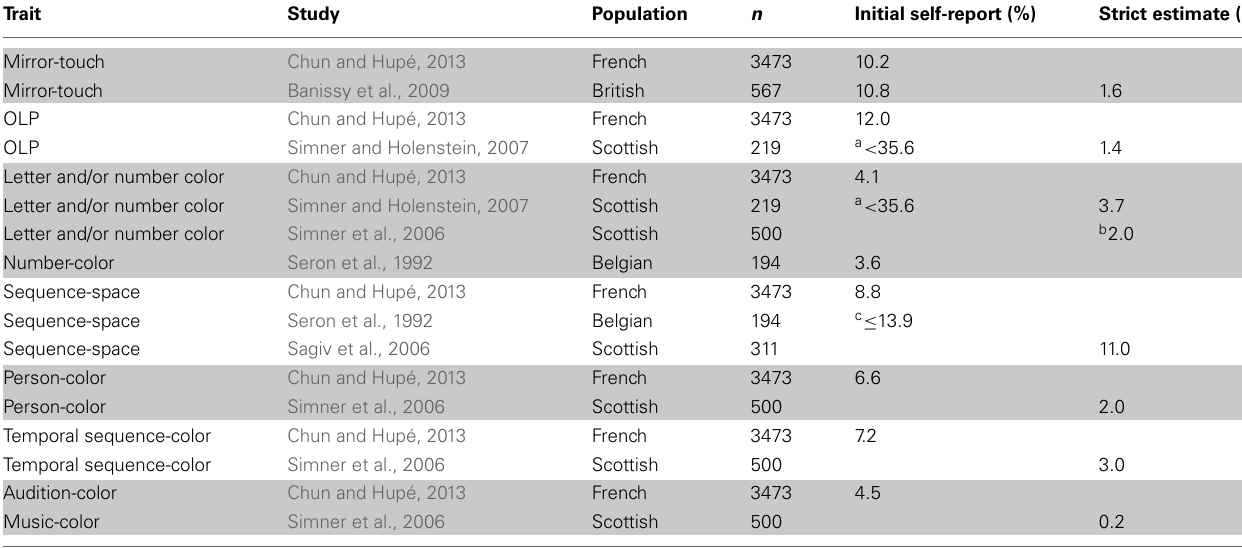
Table 3 | Prevalence